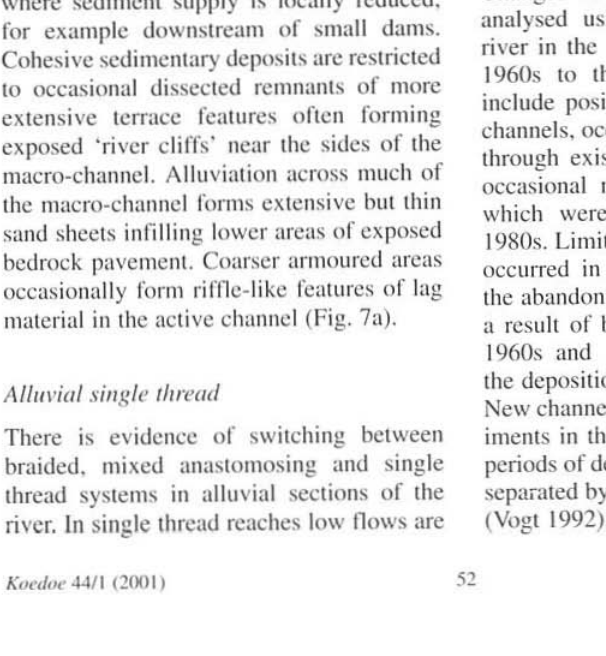
where sedimcnt supply is locally